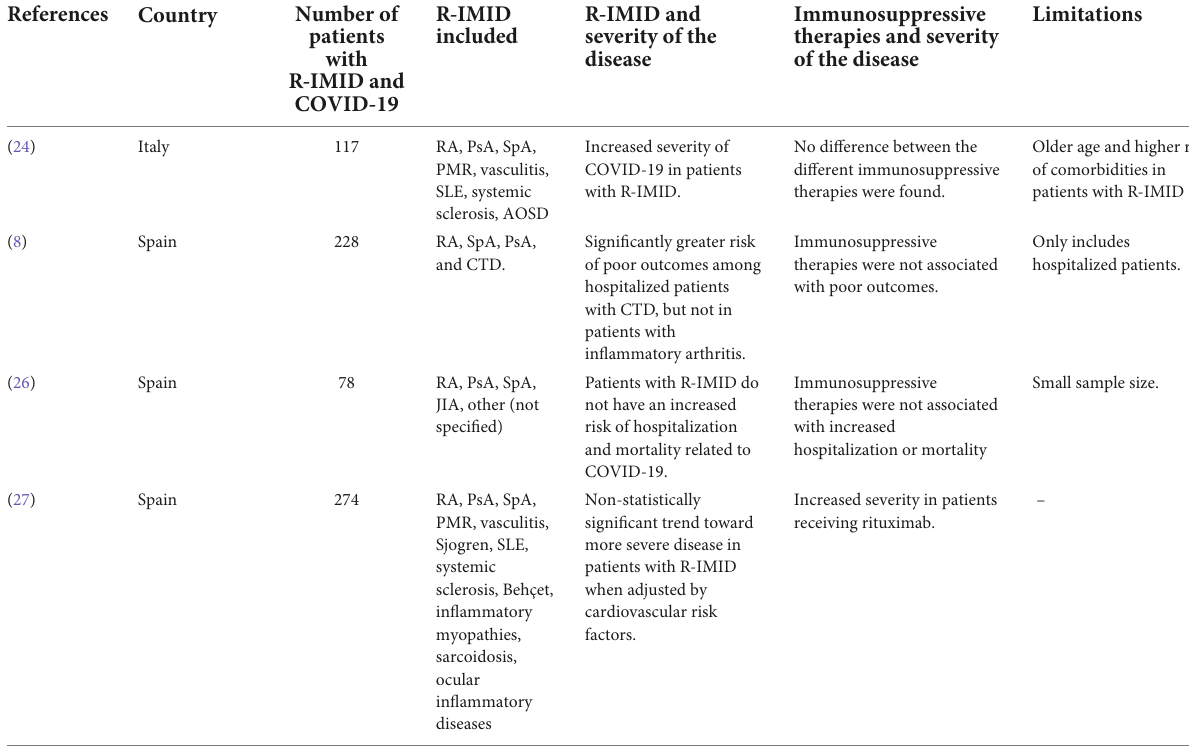
TABLE 6 Literature review of previous case-control studies in patients with rheumatic immune-mediated diseases (R-IMID) and coronavirus disease 2019